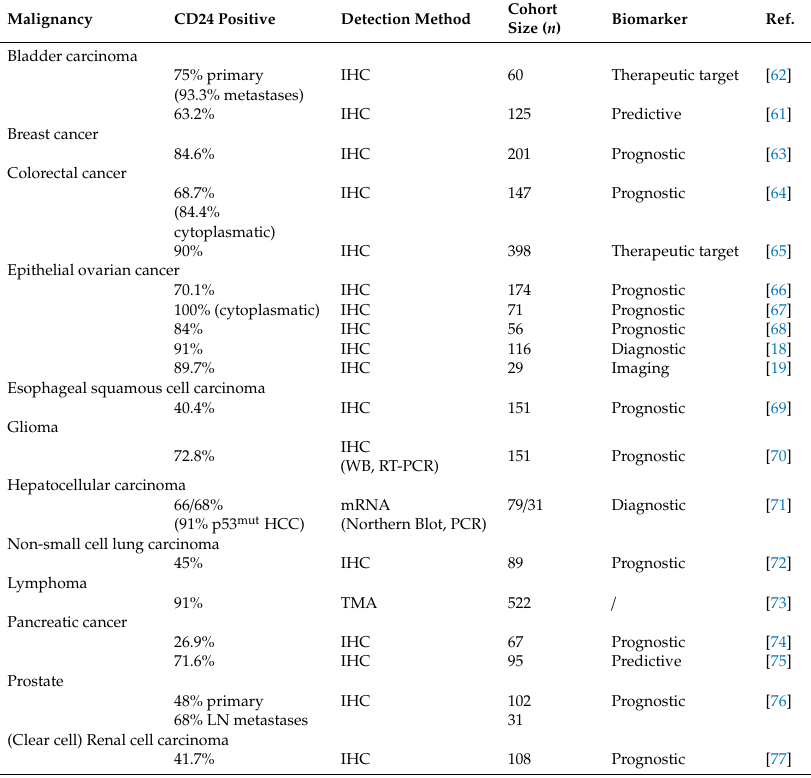
Table 2. Expression of CD24 among